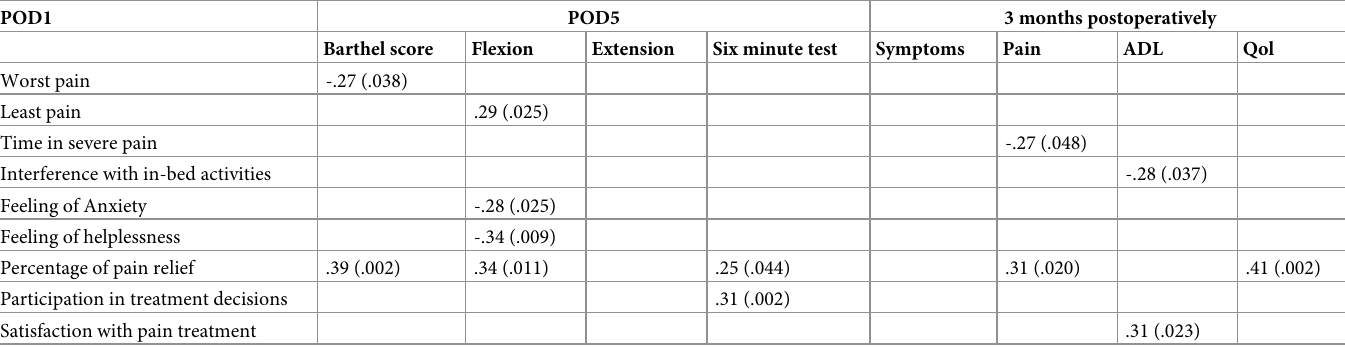
Our results revealed weak but statistically significant associations between pain related PROMs on POD1 and functional outcome parameters on POD5 and 3 months postopera- tively. Severity of ‘worst pain’, “proportion of patients out of bed” and “percentage of pain relief” on POD1 correlated with the Barthel score on POD5. “Least pain” on POD1, as well as “feeling of helplessness”, “anxiety”, and “percentage of pain relief” correlated with the degree of knee flexion on POD5. Percentage of pain relief and participation in decisions regarding pain treatment correlated significantly with the 6 minute walking test at PO5 (see Table 6). The pain intensity sub-score of KOOS at 3 months postoperatively correlated with the fre- quency of severe pain and percentage of pain relief on POD1. The quality of life sub-score 3 months postoperatively was also related to the percentage of pain relief assessed on POD1, while independence in performing ADLs 3 months postoperatively correlated with pain inter- ference with in-bed activities and satisfaction with pain treatment on POD1 (see Table 6). Significant relationships were also observed between pain related PROMs on POD5 and functional outcome measures assessed on POD5 and 3 months postoperatively. Patients who were mobilized out of bed in the last 24 hours, and felt less helpless on POD5 performed better regarding the Barthel score on POD5. Furthermore, patients who had lower scores for worst and least pain, lower frequency of severe pain, and who were more involved in pain decisions on POD5 achieved higher range of motion in terms of flexion on POD5. Pain interference with activities out of bed was related with a higher extension deficit on POD5, while patients who felt anxious on POD5 performed worse on the 6 minute test on POD5 (see Table 7). Moreover, a number of IPO-Q items on POD5 correlated significantly with functional out- come 3 months later, specifically worst pain, time in severe pain, interference with activities and participation in treatment (see Table 7).